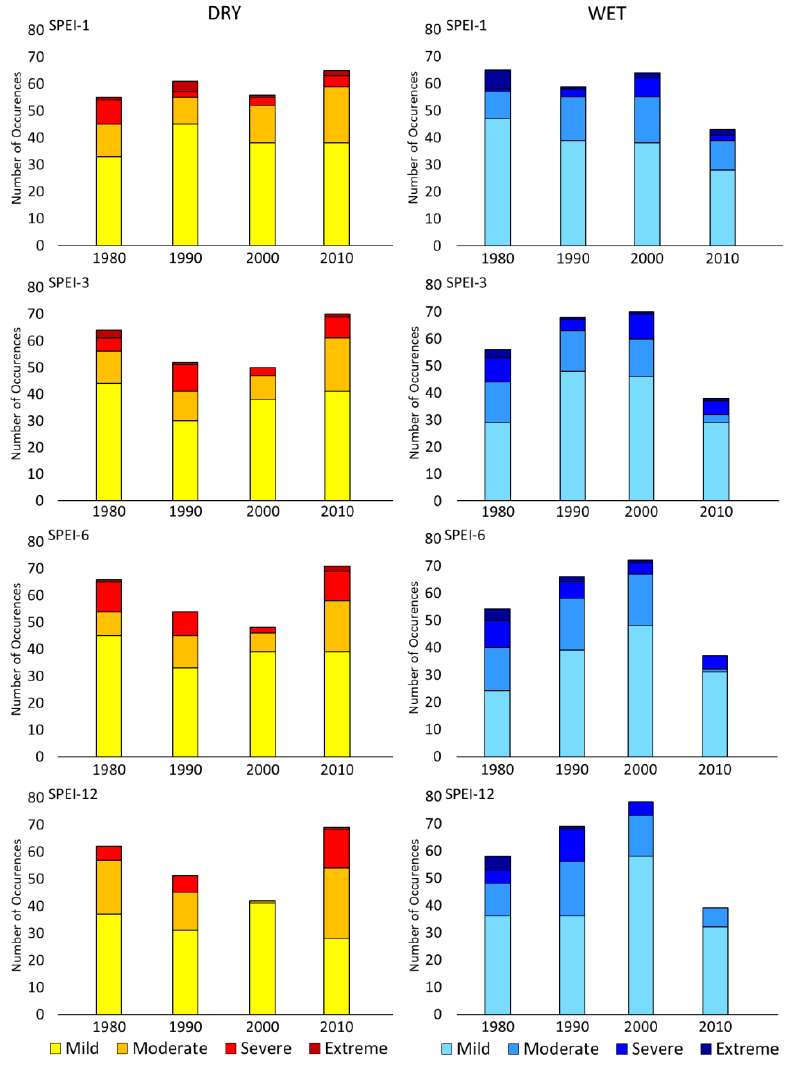
Figure 3. Number of occurrences of ESA SPEI-1, SPEI-3, SPEI-6, and SPEI-12 values at each one of the categories defined in Table 1 during the 1980s, 1990s, 2000s, and 2010s. Data are computed from CRU TS 4.03.